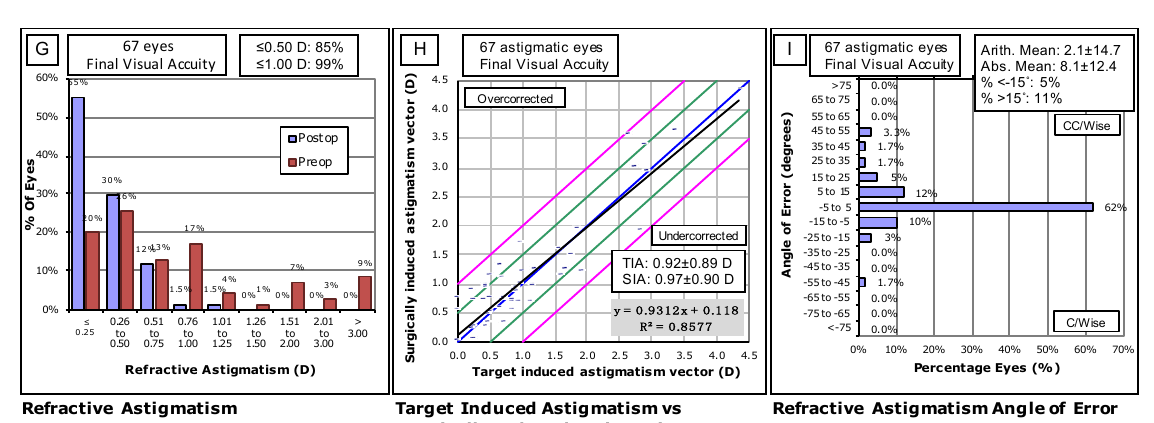
Figure 1. Standard nine graphs for reporting outcomes following refractive surgery. ( A ) Proportion of plano targeted eyes achieving a certain UDVA following repositioning compared to CDVA pre-LASIK. ( B ) Difference in Snellen lines between pre-LASIK CDVA and post-repositioning UDVA for plano targeted eyes ( C ) Difference in Snellen lines between pre-LASIK and post-repositioning CDVA. ( D ) Plot showing the association between final achieved SEQ following repositioning compared to pre-LASIK attempted SEQ. The blue line indicates attempted = achieved. Green lines indicate +/ − 0.50 D. Pink Lines indicate +/ − 1.00 D. ( E ) Accuracy of final post-repositioning SEQ compared to pre-LASIK target SEQ ( F ) Stability of mean SEQ over the follow-up period following repositioning. ( G ) Proportion of eyes achieving a certain astigmatism (D) before and after LASIK and repositioning procedures. ( H ) Plot showing the association between target induced astigmatism (TIA) and surgically induced astigmatism (SIA) following repositioning compared to pre-LASIK TIA vector. The blue line indicates attempted = achieved. Green lines indicate +/ − 0.50 D. Pink lines indicate +/ − 1.00 D. ( I ) Final angle of error of astigmatism post-repositioning SIA compared to pre-LASIK